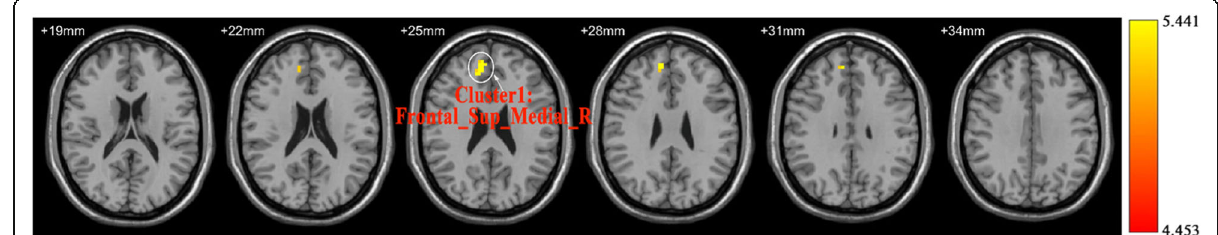
Fig. 1 The regional homogeneity (ReHo) differences in the conventional band of 0.01 – 0.08 Hz. Warm colors indicate regions showing higher